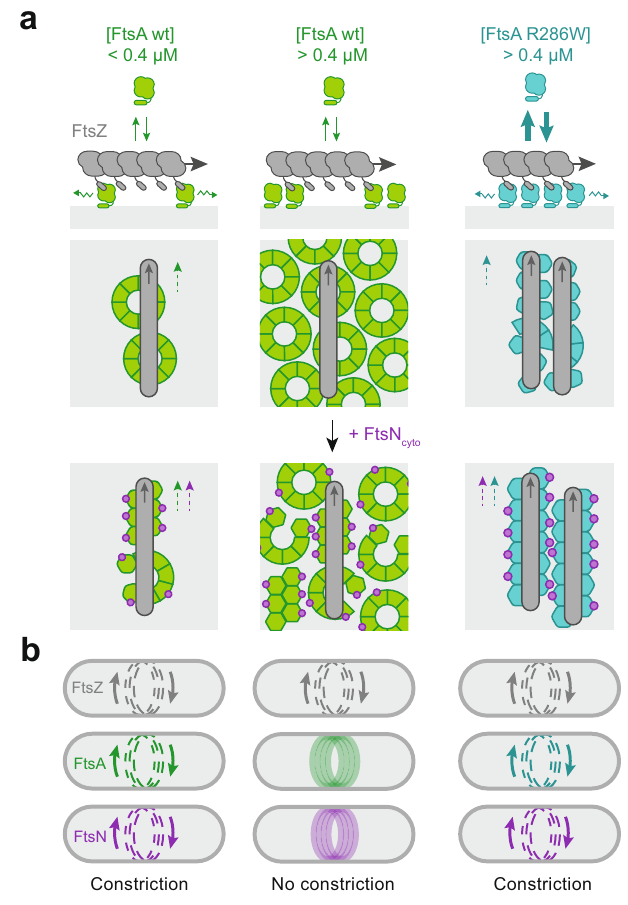
Fig. 5 A model for the behaviour of FtsA during divisome activation. The spatiotemporal distribution of FtsA is the result of its dynamic interaction with treadmilling FtsZ fi laments and the lipid membrane. Grey arrows indicate FtsZ treadmilling direction, green and cyan arrows represent cycling exchange of FtsA by reversible membrane binding, wavy arrows represent diffusion on the membrane surface, dashed arrows indicate co- treadmilling of FtsA and FtsN with FtsZ. a Left: At low FtsA WT concentrations, i.e. at a protein ratio found in vivo ([FtsA WT] = 0.2 µ M, [FtsZ] = 1.25 µ M), diffusion of membrane-bound FtsA is fast enough to allow for co-treadmilling despite slow-cycling rates. The presence of FtsA WT minirings limits the packing density and therefore its amount recruited to FtsZ fi laments. Furthermore, FtsA minirings allow for a continuous realignment of treadmilling fi laments. Binding of FtsN cyto leads to the formation of FtsA-FtsN copolymers that follow treadmilling FtsZ fi laments and limits their reorganization. Middle: At higher concentrations, FtsA WT forms a continuous array of minirings, stabilized by lateral interactions. Due to the absence of diffusion, FtsA cannot follow FtsZ treadmilling dynamics. Right: Even at high FtsA R286W concentrations, its fast exchange allows co-treadmilling with FtsZ fi lament. Loss of longitudinal interactions in FtsA R286W disrupts minirings and allows for a higher packing density, which limits the realignment of FtsZ fi laments. Binding of FtsN further enhances lateral interactions to promote the formation of FtsA double fi laments that further limits realignment of FtsZ fi laments. b In vivo, low concentrations of FtsA WT allow for continuous co-treadmilling of FtsZ, FtsA and downstream proteins around the cell diameter, where they distribute cell wall synthesis allowing for cell constriction. When overexpressed, FtsA WT as well as its binding partner FtsN stop following FtsZ treadmilling, cell wall synthesis is not distributed and the cell fails to divide. In the case of FtsA R286W, its fast membrane cycling rate and faster diffusion allows for a dynamic distribution of proteins, constriction and cell division, even when